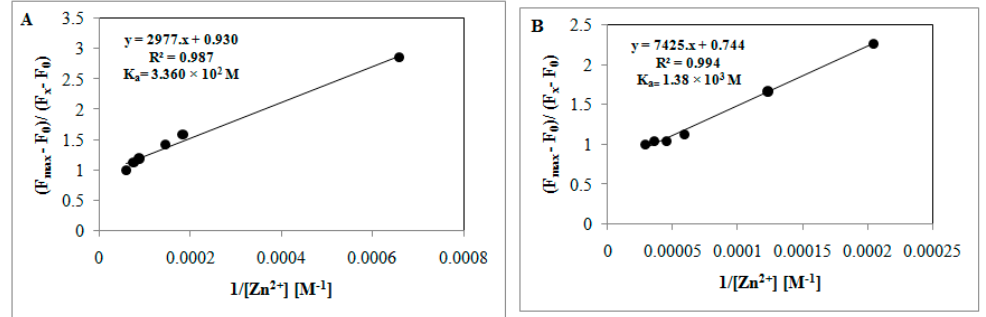
Figure 12. The association constant (K a ) of each sensor with Zn 2+ was calculated by Benesi–Hildebrand equation for Fe 3 O 4 -H@hpbtz ( A ) and MSN-Et 3 N-IPTMS-hpbtz- f1 ( B ).